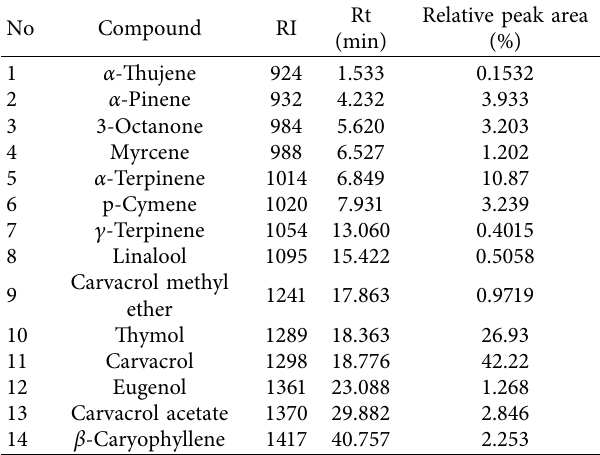
Table 1: Chemical compounds (%) of essential oil of Z. multiflora .